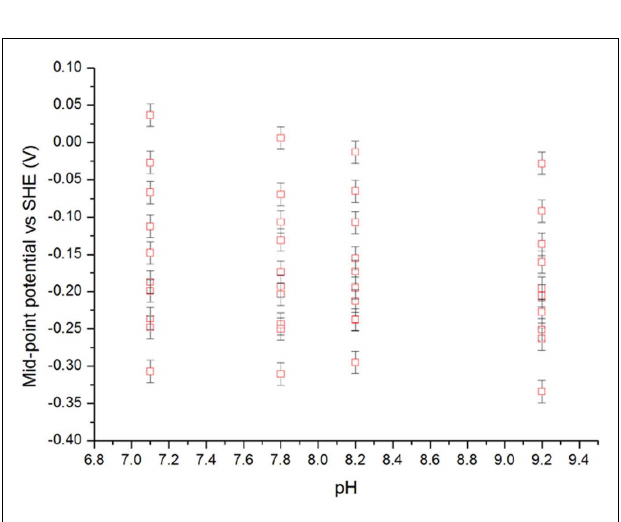
FIGURE 5 |Average E m values determined from cyclic voltammetry of MtoA at the indicated pH.